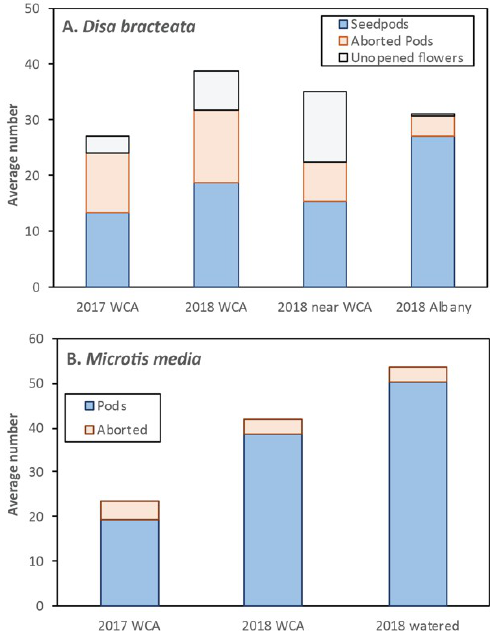
Figure 9. Effect of climate on flowering and capsule production for two self-pollinating orchids; ( A ) Disa bracteata ; ( B) Microtis media.